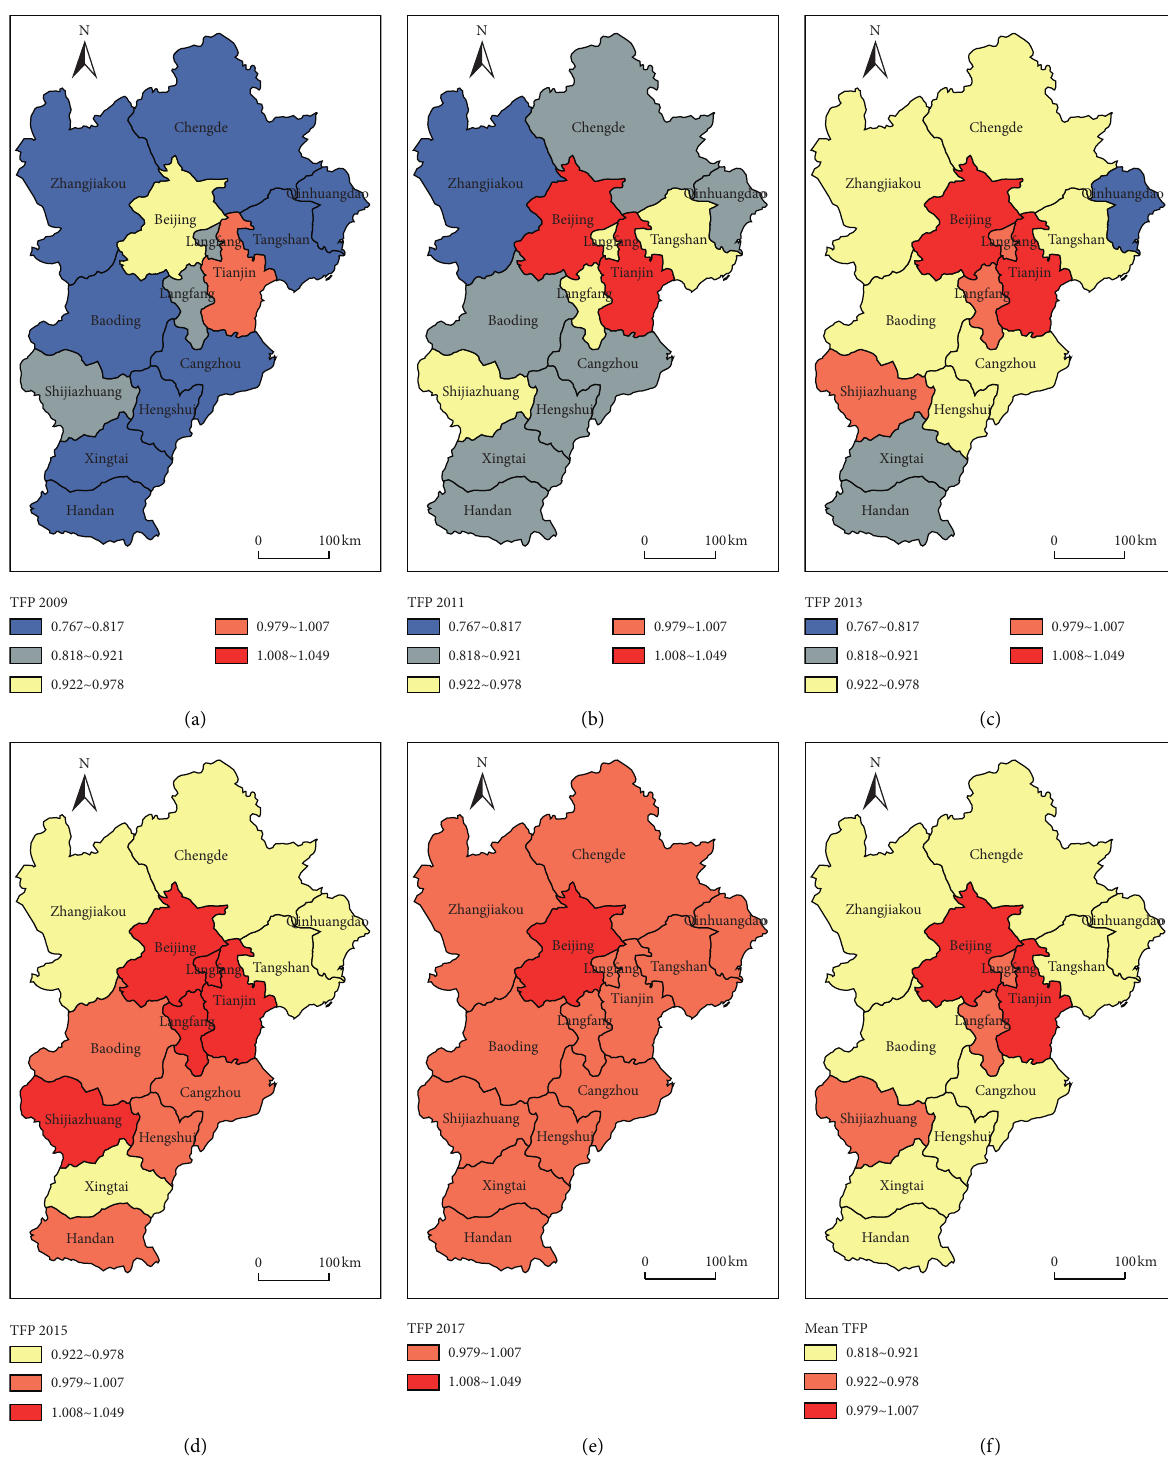
Figure 2: TFP spatial pattern of Beijing-Tianjin-Hebei Metropolitan